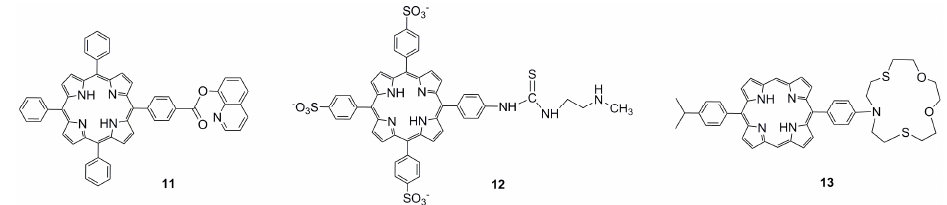
Figure 3. Structural formula of porphyrins modified with sulfur and oxygen atoms. Reproduced from ref [35,36,42].